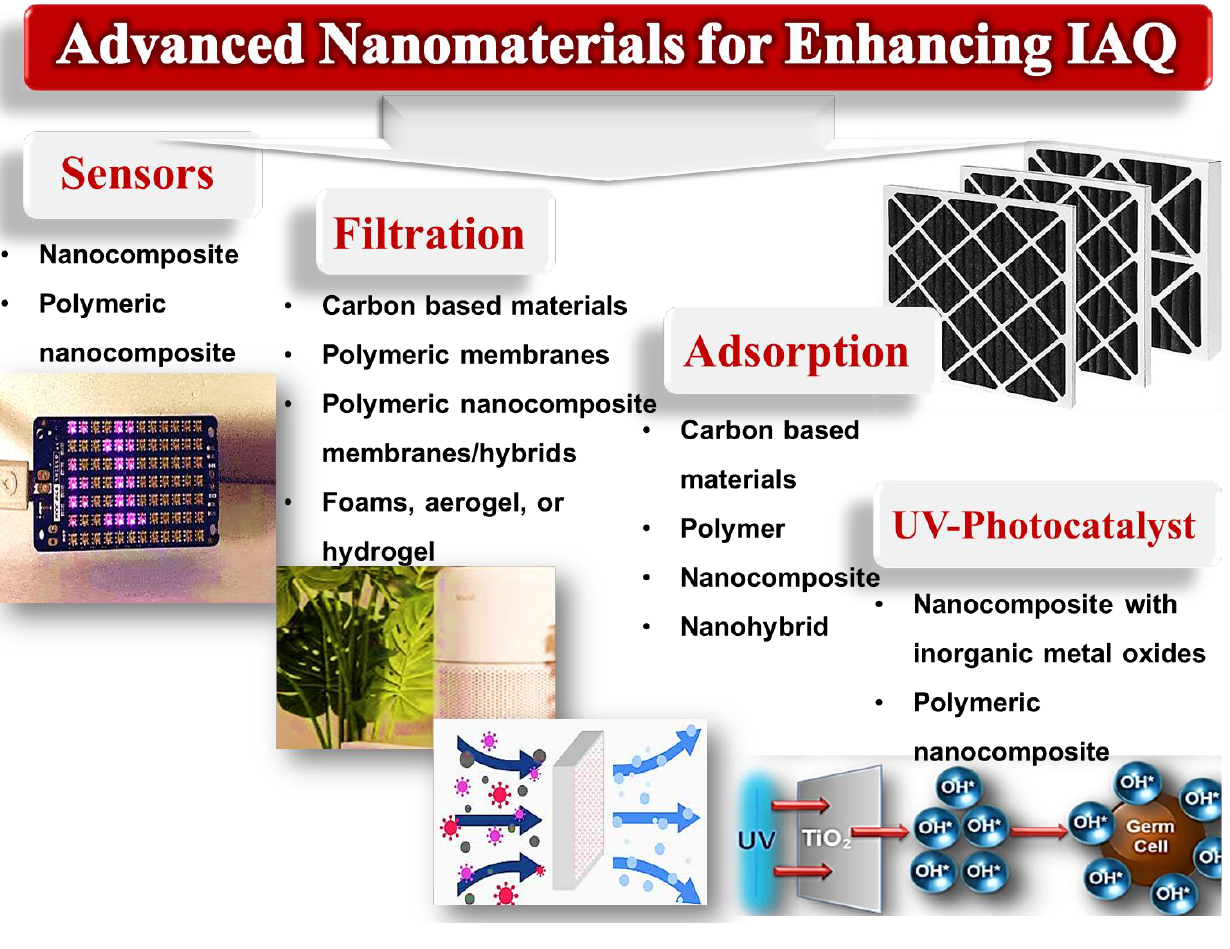
Figure 5. Advanced nanomaterials for enhancing